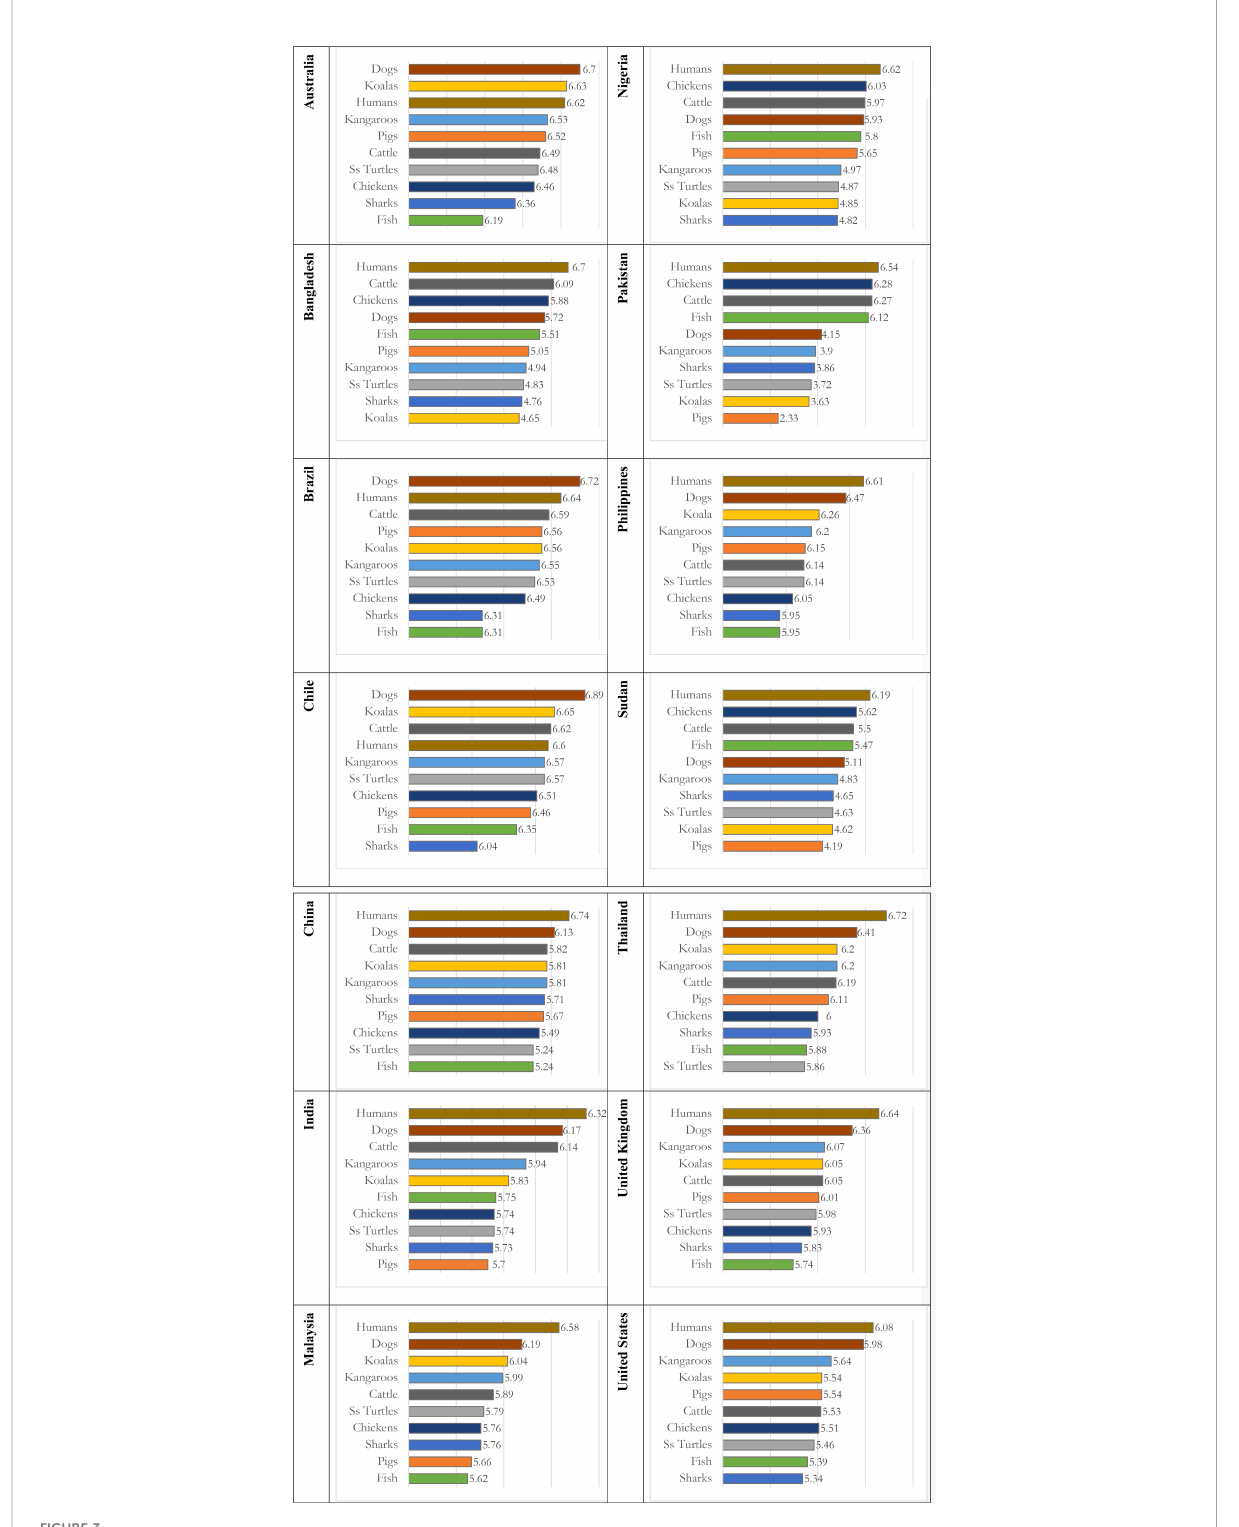
FIGURE 3 Means ranking of considered importance of the welfare of speci fi c species, by country, according to 7-point Likert